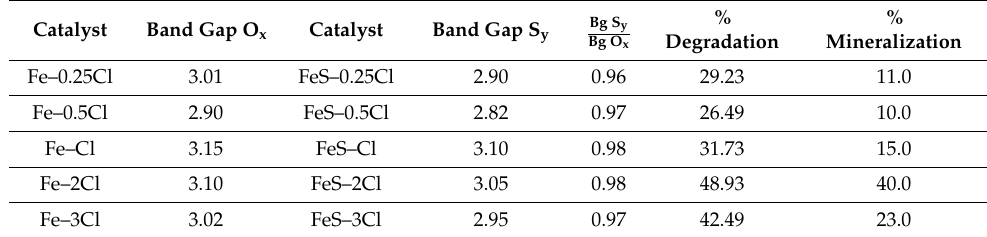
Figure 20. Sulphide band gap vs. degradation and mineralization ratio.